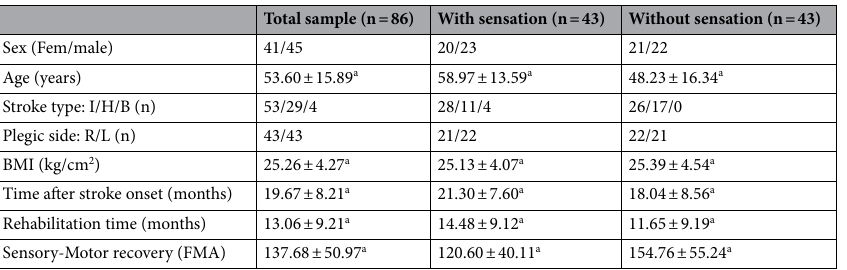
Table 1. General characteristics of post-stroke patients. I ischemic, H hemorrhagic, B both, R right, L left, BMI body mass index, kg kilogram, cm centimeters, FMA Fugl-Meyer assessment. a Mean ± standard deviation.